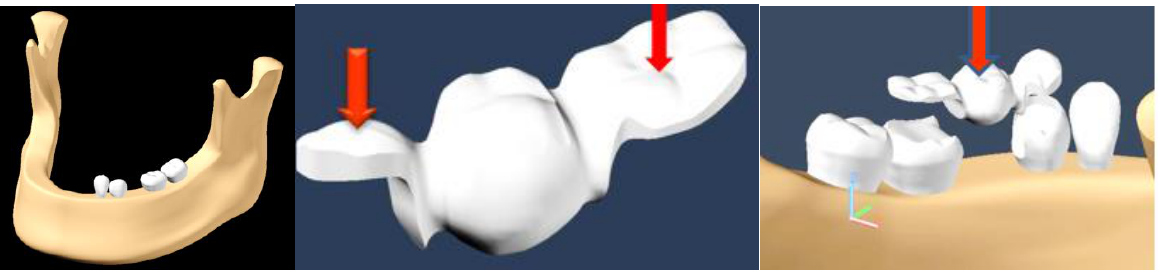
Figure 2. The models of the mandible and the